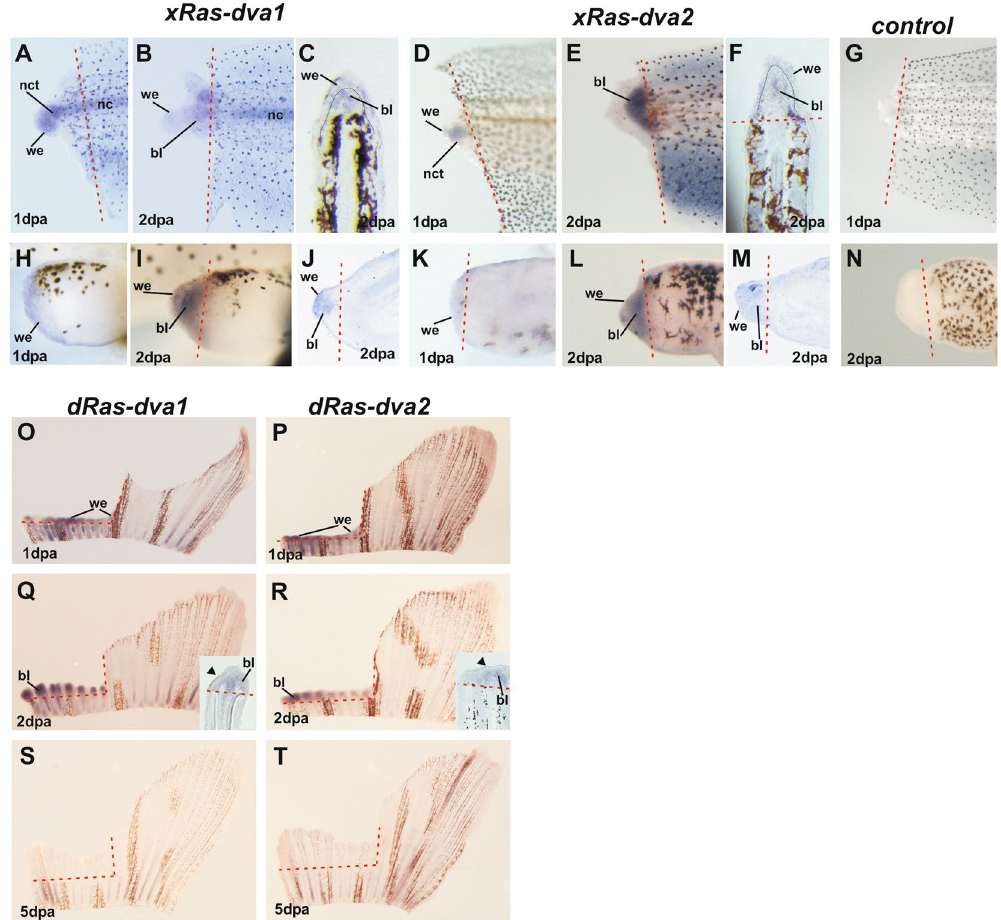
Figure 3. Analysis of Ras-dva1 and Ras-dva2 expression patterns during regeneration by whole-mount in situ hybridization. ( A – F ) Expression of xRas-dva1 and xRas-dva2 in X. laevis tadpole’s tails at 1 and 2 dpa in whole- mount tails ( A , B , D , E ) and on tail cryosections ( C , F ). At 1 dpa xRas-dva1 transcripts were revealed in wound epithelium, notochord and notochord tip cells ( A ). At 2 dpa expression is shown in wound epithelium and blastema cells ( B,C ). Expression of xRas-dva2 in X. laevis tadpole’s tails on 1 dpa is very poor in wound epithelium and notochord tip cells ( D ) and by 2 dpa it is strongly activated in blastema cells ( E,F ). ( G , N ) Tail 1 dpa and hindlimb 2 dpa stumps after whole-mount in situ hybridization with control ( sense xRas-dva1 + sense xRas-dva2 ) probe respectively. ( H – M ) Expression of xRas-dva1 and xRas-dva2 in X. laevis tadpole’s hindlimb stumps at 1 and 2 dpa respectively. At 1 dpa expression of both genes is seen in wound epithelium and by 2 dpa – in blastema cells as well (see cryosections J , M ). Lateral view, distal to the left, dorsal to the top. ( O – T ) The D. rerio caudal fins with amputated left part after hybridization in situ with dRas-dva1 ( O , Q,S ) or dRas-dva2 ( P , R,T ) probe at 1, 2 and 5 dpa. The inserts on Q and R show ISH signal in 2 dpa fin cryosections. Black arrowhead – wound epithelium. Lateral view, distal to the top, dorsal to the left. Dashed red line marks the level of amputation, black dotted lines on C and F mark the wound epithelium boundary, we – wound epithelium, bl – blastema, nct – notochord